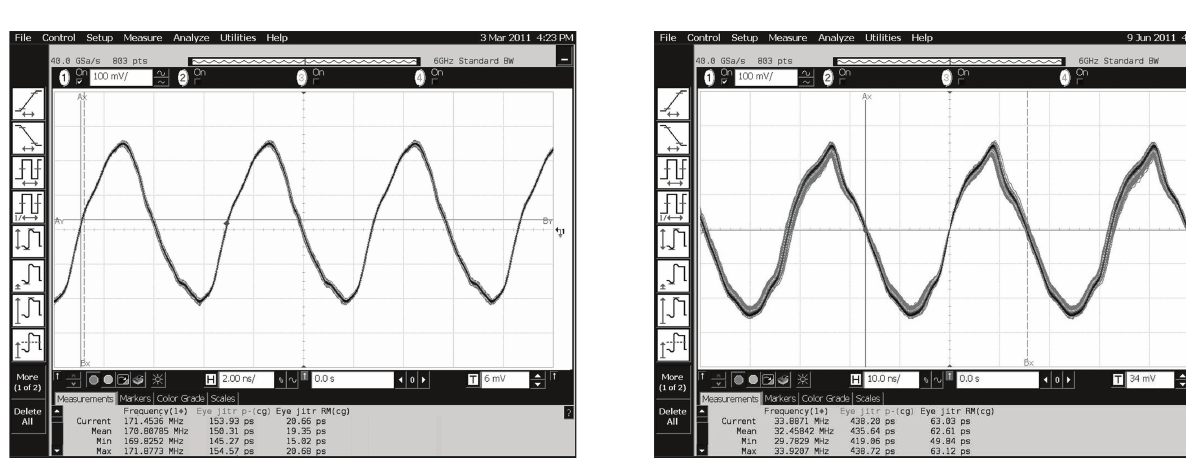
Figure 16: Measured results of multiphase ADPLL’s output at 171MHz with P k - P k = 150 . 3 ps.